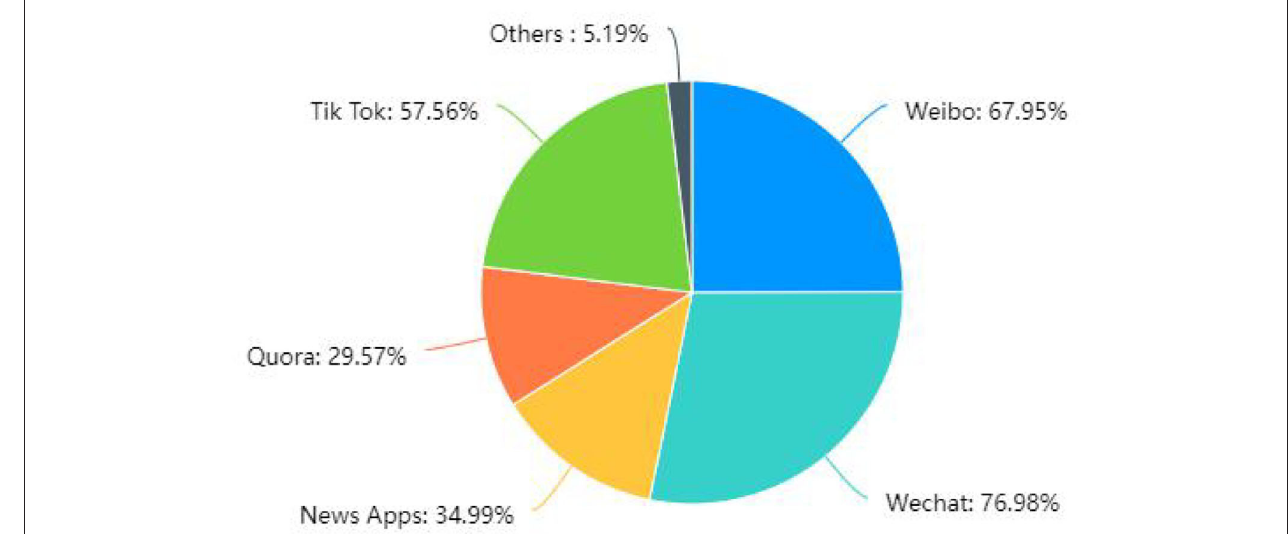
FIGURE 2 | Access to information for users during the COVID-19 outbreak.